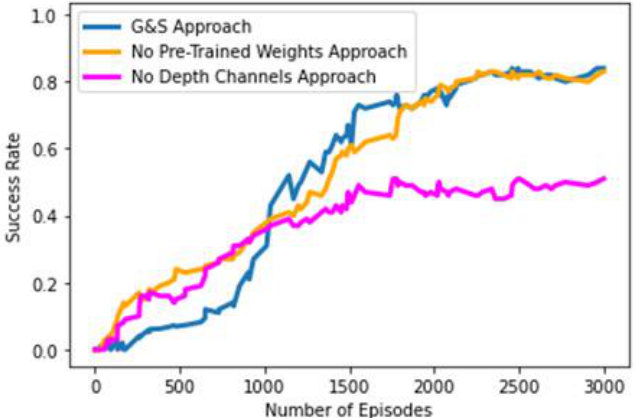
Figure 15. Performance comparison of original G&S approach, no-pre-trained-weights approach, and no-depth-channels approach.